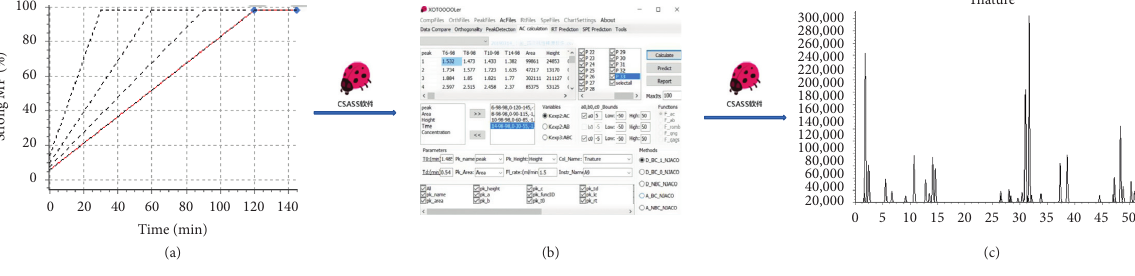
Figure 1: Flow diagram of optimizing elution conditions by